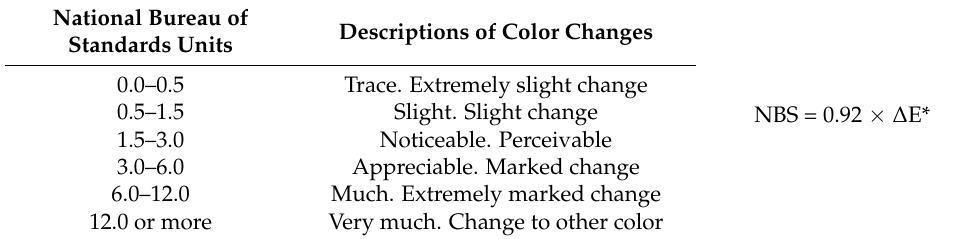
Table 2. National Bureau of Standards (NBS) units. Description of color